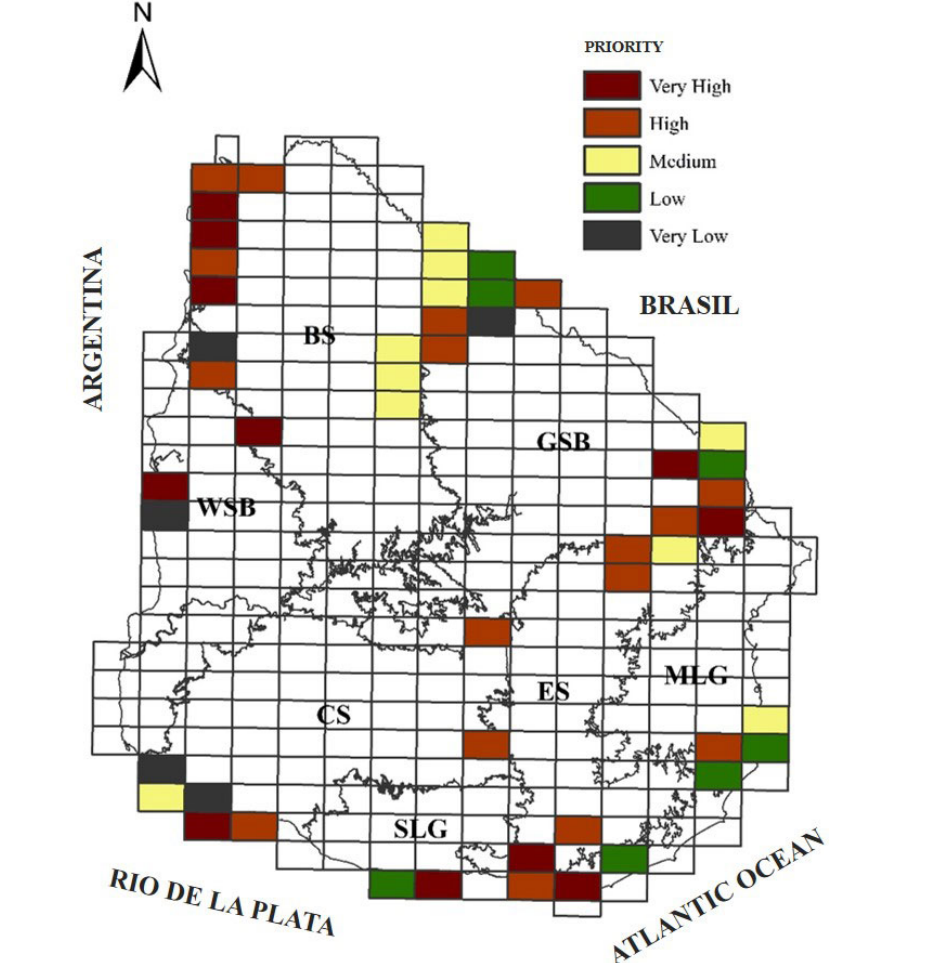
Fig. 6 . Spatial prioritization of the highest vulnerable cells (top 17%) for conserving vertebrate and woody plant diversity in the face of agricultural expansion in Uruguay. Very low priority was assigned to currently converted cells (i.e., habitat loss > 50% in 2015). Protected cells (i.e., overlapping with protected areas of the national system) were classified as low priority for conservation. Currently unprotected cells (i.e., without protected areas) were classified according to the conversion probability in the 2030-scenario in: medium priority (habitat loss < 20%), high priority (habitat loss between 21 and 50%), and very high priority (habitat loss > 50%). The ecoregions of Uruguay are indicated according to the following codes: Western Sediment Basin (WSB), Basaltic Slope (BS), Crystalline Shield (CS), Gondwanic Sediment Basin (GSB), Merin Lagoon Graben (MLG), Santa Lucía Graben (SLG), and Eastern Sierras